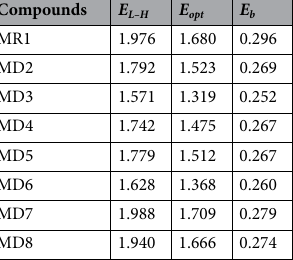
Table 6. Calculated first singlet to singlet excitation state energy ( E opt ) and binding energy ( E b ) of inspected compounds. Units in eV.